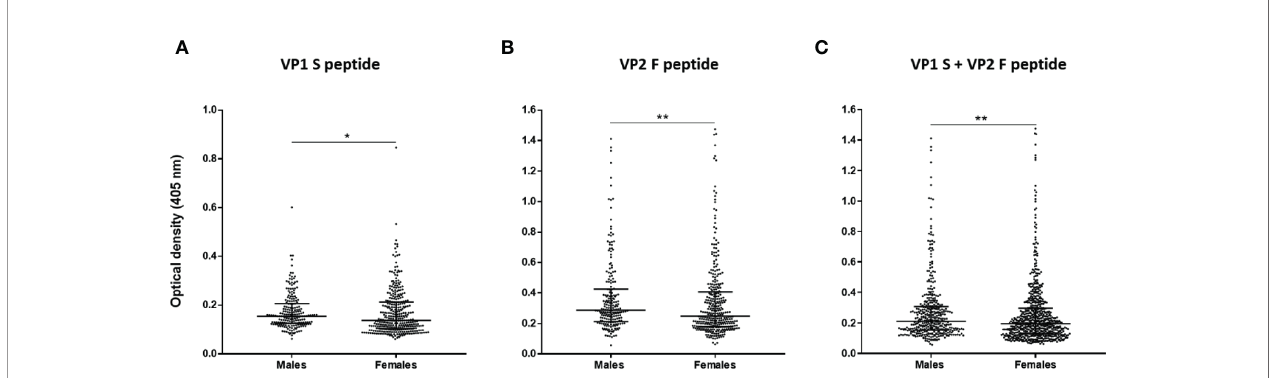
FIGURE 5 | Serologic pro fi les of serum antibody reactivity to MCPyV peptides in gender-strati fi ed healthy subjects (HS). Analyses were performed with VP1 S (A) , VP2 F (B) peptides and for combined VP1 S and VP2 F (C) in gender-strati fi ed HS. Immunologic data derived from males (n=210) and females (n=338) HS. Results are presented as OD value readings at l 405nm for serum samples assayed in indirect ELISA. In the scatter dot plot, each dot represents the dispersion of ODs for each sample. The median is indicated by the line inside the scatter plot with the interquartile range (IQR) for each group of subjects analyzed. (A) * p<0.05; (B) ** p<0.01; (C) **